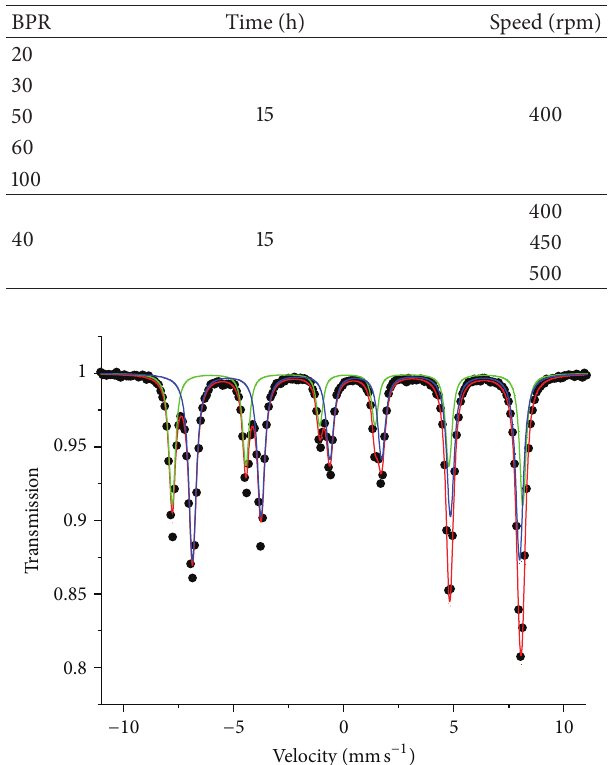
Table 1: F O /C (1:3 mole ratio) milling conditions. 3 4